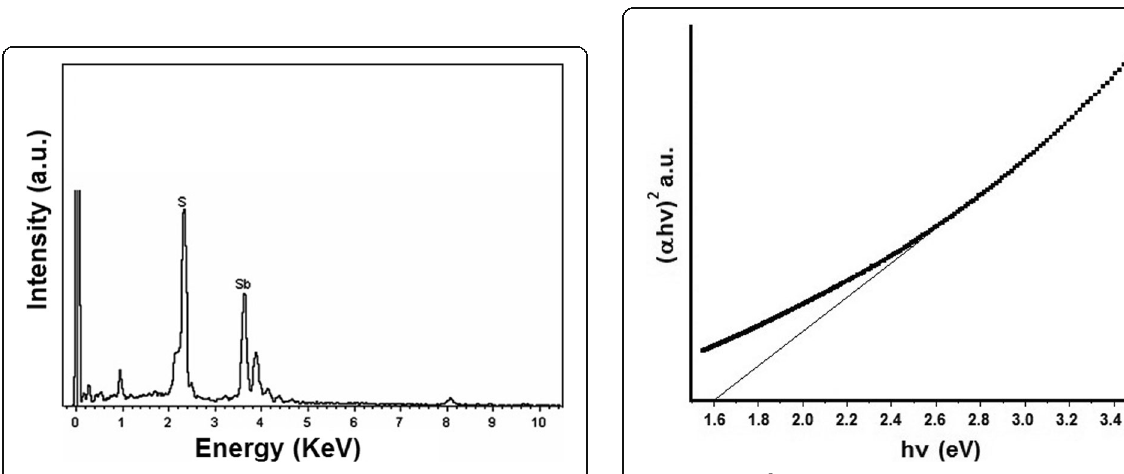
Fig. 4 EDX spectrum of 0.3 HEC-Sb 2 S 3 product Fig. 5 The ( α h ν ) 2 and h ν plot of 0.3 HEC-Sb 2 S 3